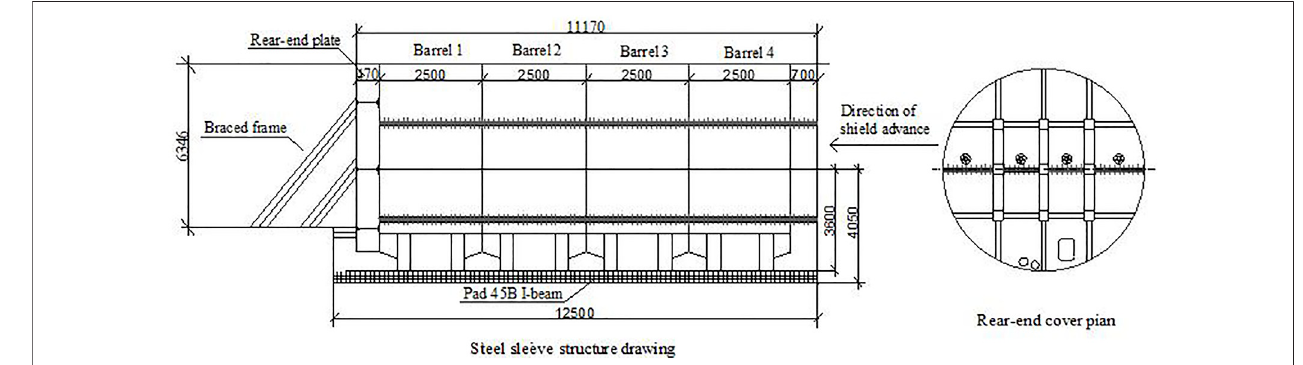
FIGURE 4 | Structural drawings of steel sleeve.